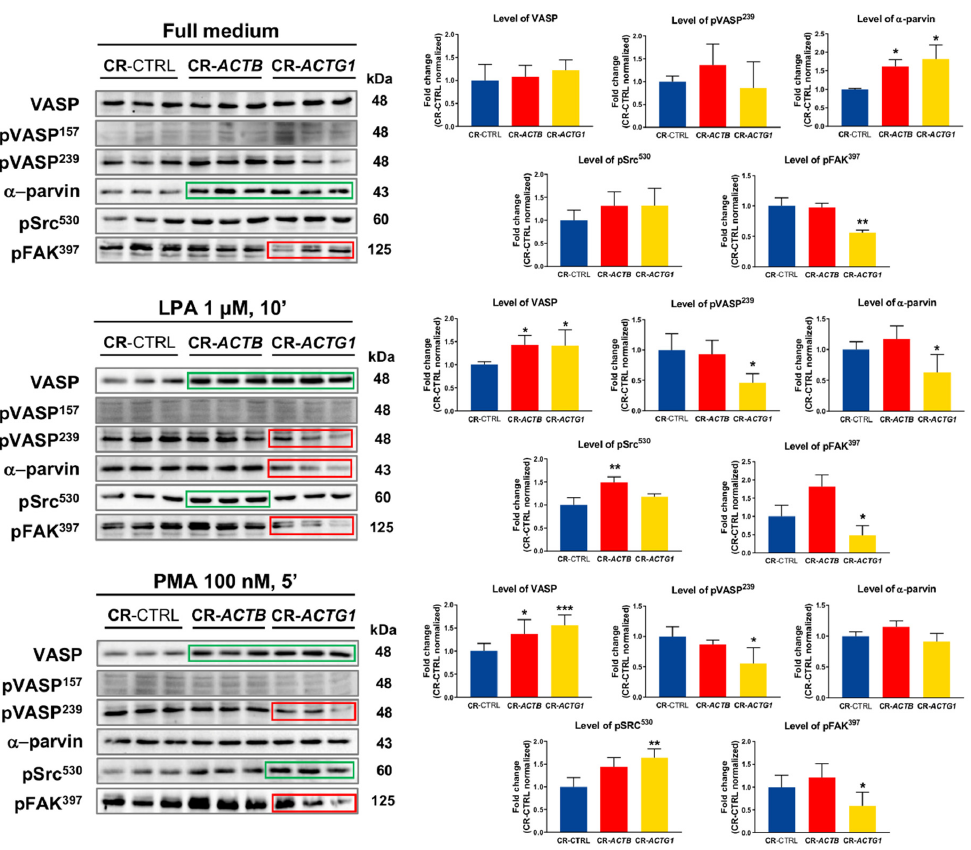
Figure 9. Changed FAs’ signaling in CR-CTRL, CR- ACTB, and CR- ACTG1 clones. Western blot analysis of control clones and clones without given isoactin. Corresponding Ponceau S stainings of membranes are shown in Figure S14. Forty µ g of protein was loaded on every lane. Membranes were probed for proteins found within focal adhesions and playing a significant role in FAs’ signaling: VASP, phosphorylated at Ser157 VASP (pVASP 157 ), phosphorylated at Ser239 VASP (pVASP 239 ), α -parvin, phosphorylated at Tyr530 proto-oncogene tyrosine-protein kinase Src (pSrc 530 ), and phosphorylated at Tyr397 focal adhesion kinase 1 (pFAK 397 ). Densitometric analysis of studied proteins levels in tested clones was done and presented as bar charts ( n = 3–6). Green and red rectangles represent statistically higher and lower level of protein, respectively, in comparison to control cells. Results are expressed as the mean ± SD, p ≤ 0.05 (*), p ≤ 0.01 (**), p ≤ 0.001 (***).